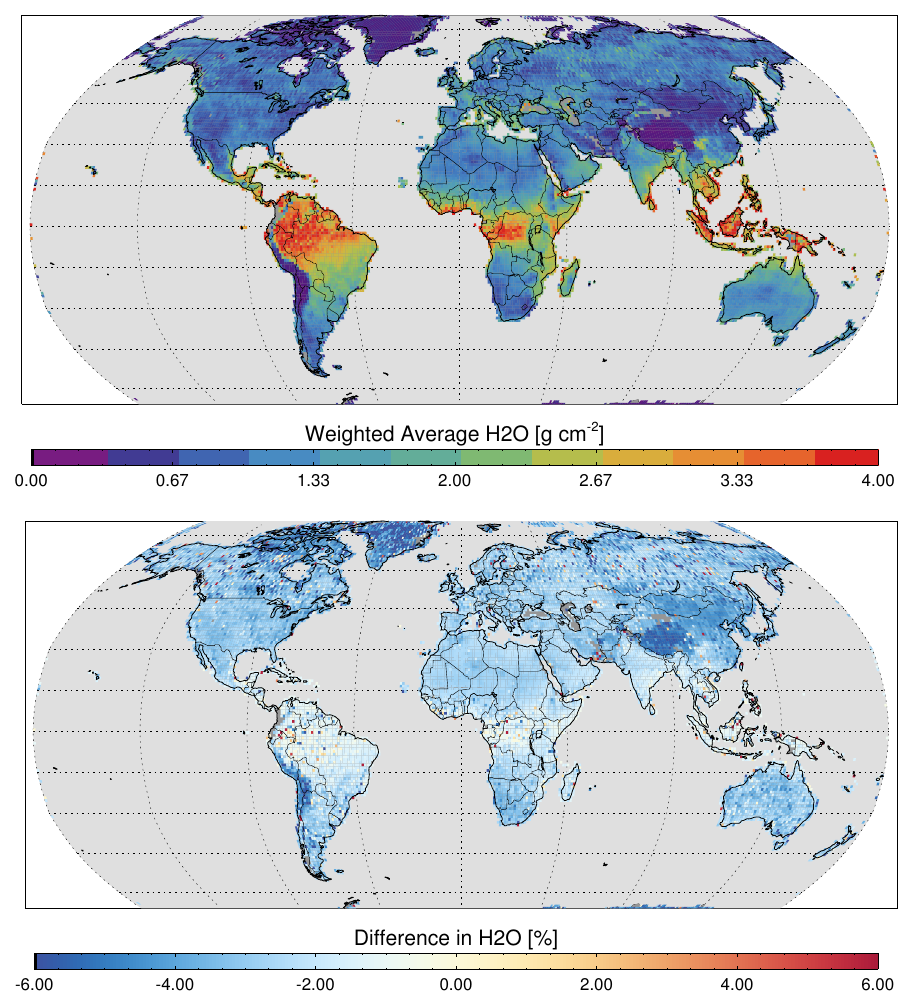
Fig. 13. Top: 2005–2007 weighted average of water vapour using the IMLM retrieval algorithm with the original Jenouvrier et al. (2007) line parameters. Bottom: relative differences (new–original/original) caused by the updated water